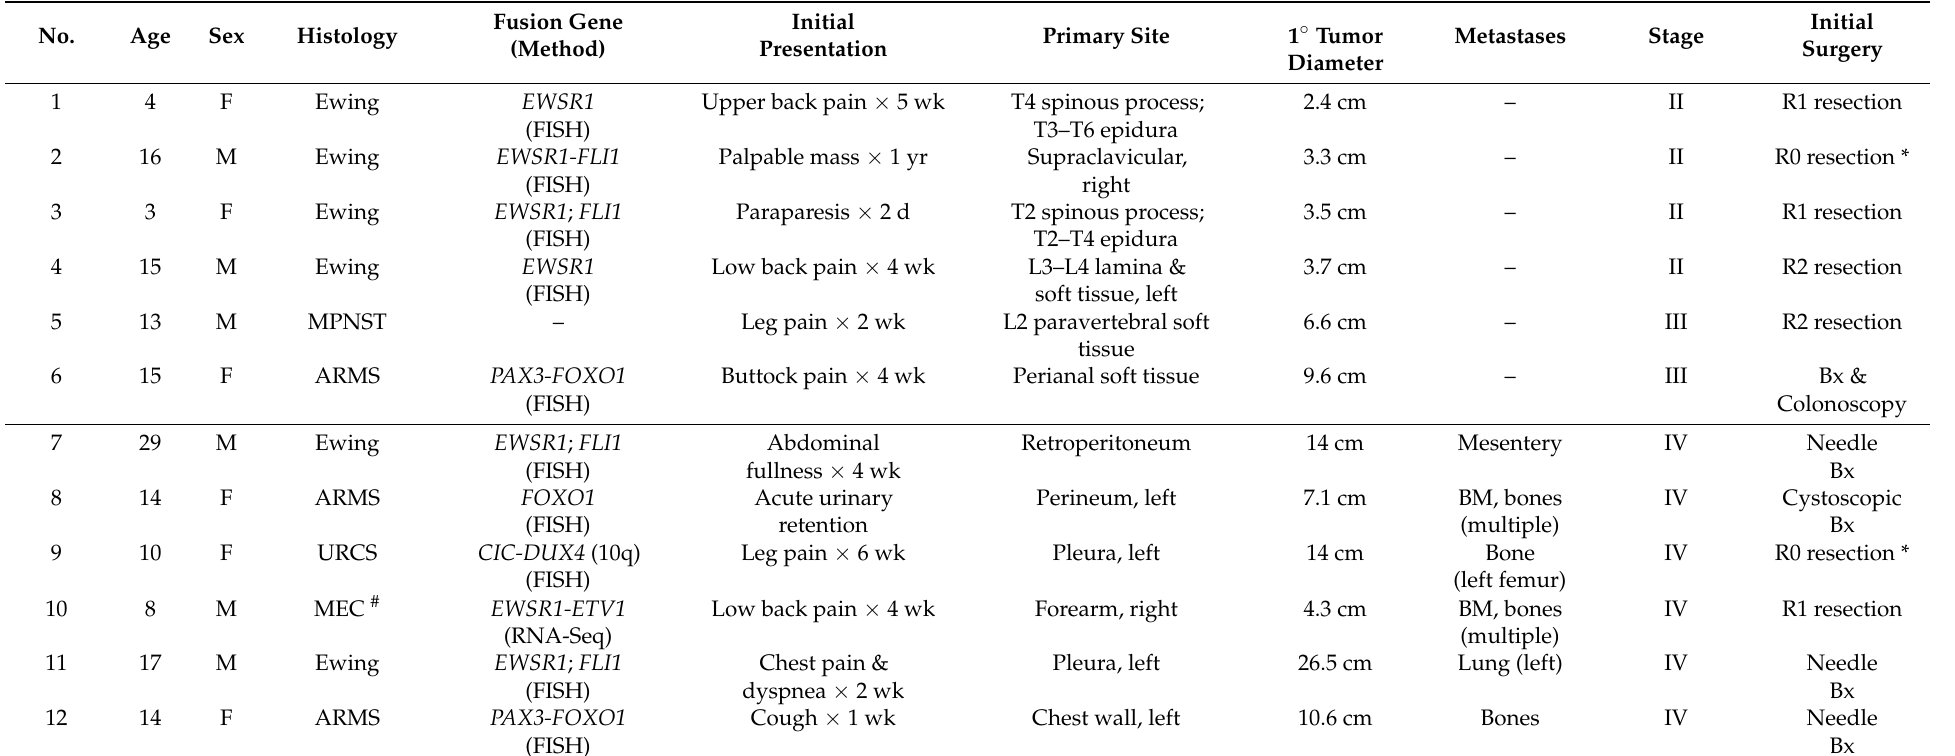
Table 1. Clinical characteristics, histopathology, and molecular features of Asian patients with